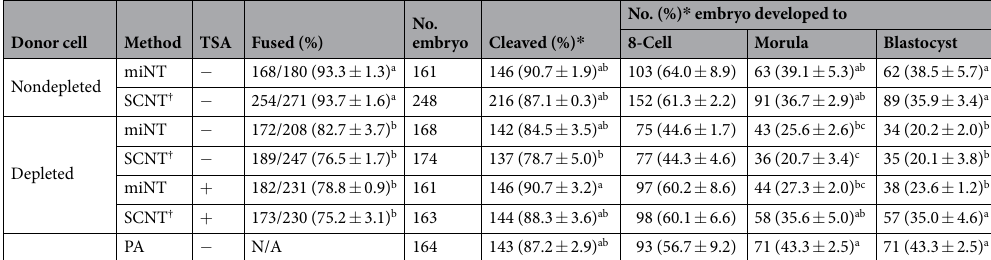
Table 1. Developmental potential of miNT and SCNT embryos generated from mtDNA depleted and nondepleted donor cells in the presence and absence of TSA. miNT, mitochondrial supplementation in combination with SCNT; SCNT: Somatic cell nuclear transfer; PA: Parthenogenetic activation. − , absence of TSA; + , presence of TSA; TSA, Trichostatin A. * Percentages calculated from the number of embryos that cleaved and developed to each stage. † Data from our previous report 50 . Values are mean ± SEM. Four replicates per treatment. Different superscripts within a column indicate significant differences (P < 0.05, ANOVA with Duncan’s multiple range test using SAS version